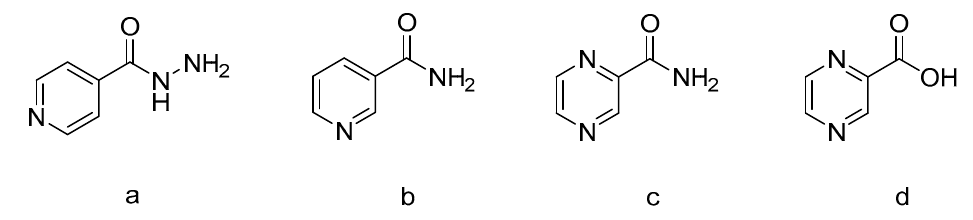
Figure 1. The chemical structure of ( a ) INH; ( b ) nicotinamide; ( c ) PZA; and POA ( d ).